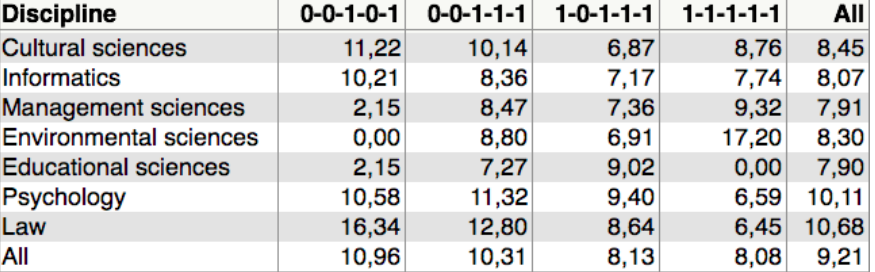
Associations are also found on the number of study points obtained in the last year by enrolled students in the various disciplines and the preference profiles (Table 7). The differences are significant in the field of law (p<0.02; connecting letters resp. A(AB)BB for the 4 profiles). For the others, the variance is too high relative to the number of cases to attain sufficient power. In law, the preference profiles with self-study characteristics are obtaining more study points per year.